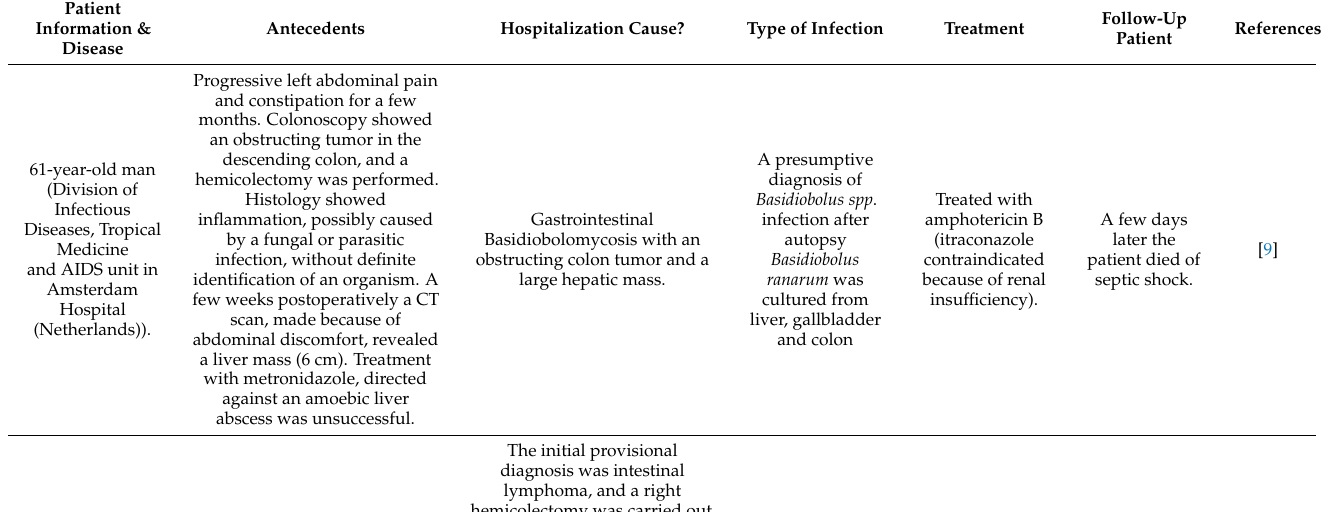
Table 1. Summary of the reported cases of Basidiobolomycosis with colonic and liver